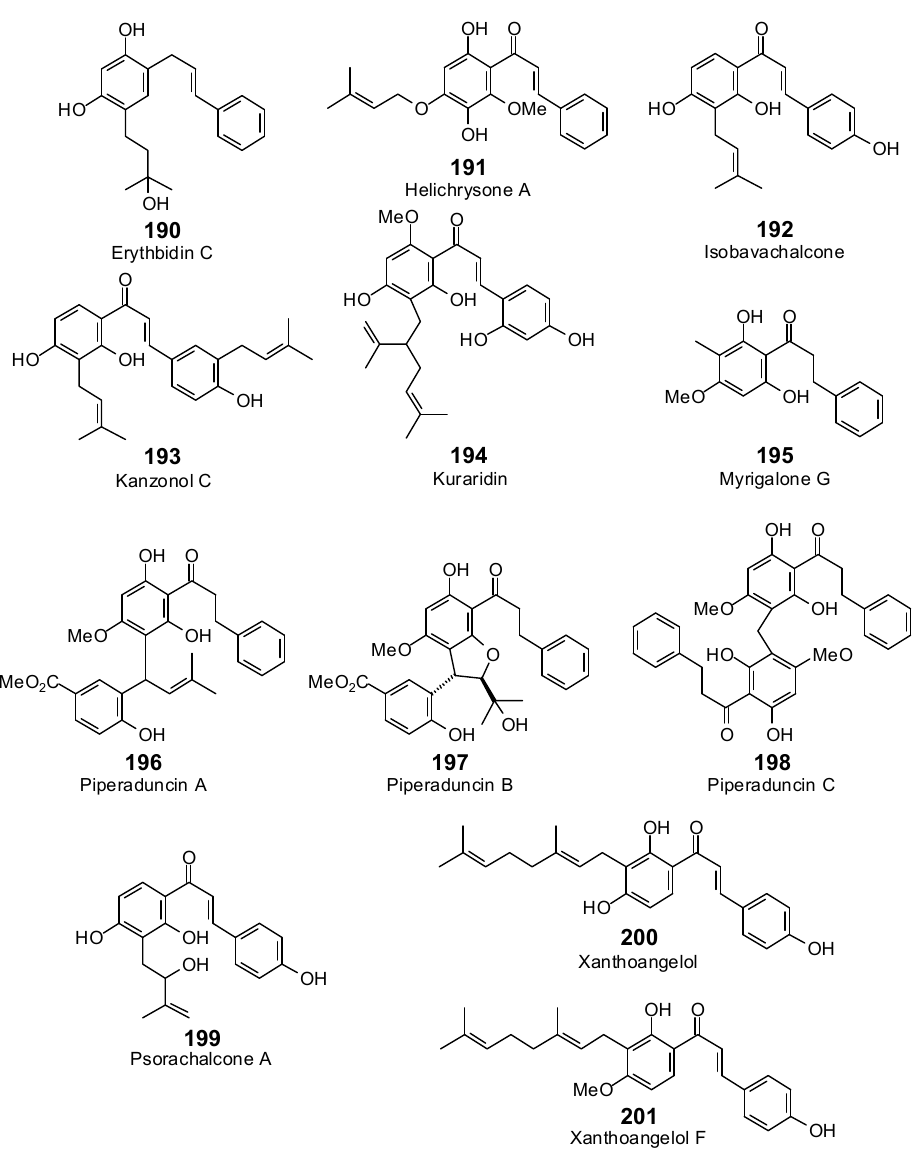
Figure 9. Chalcones examined in this work.